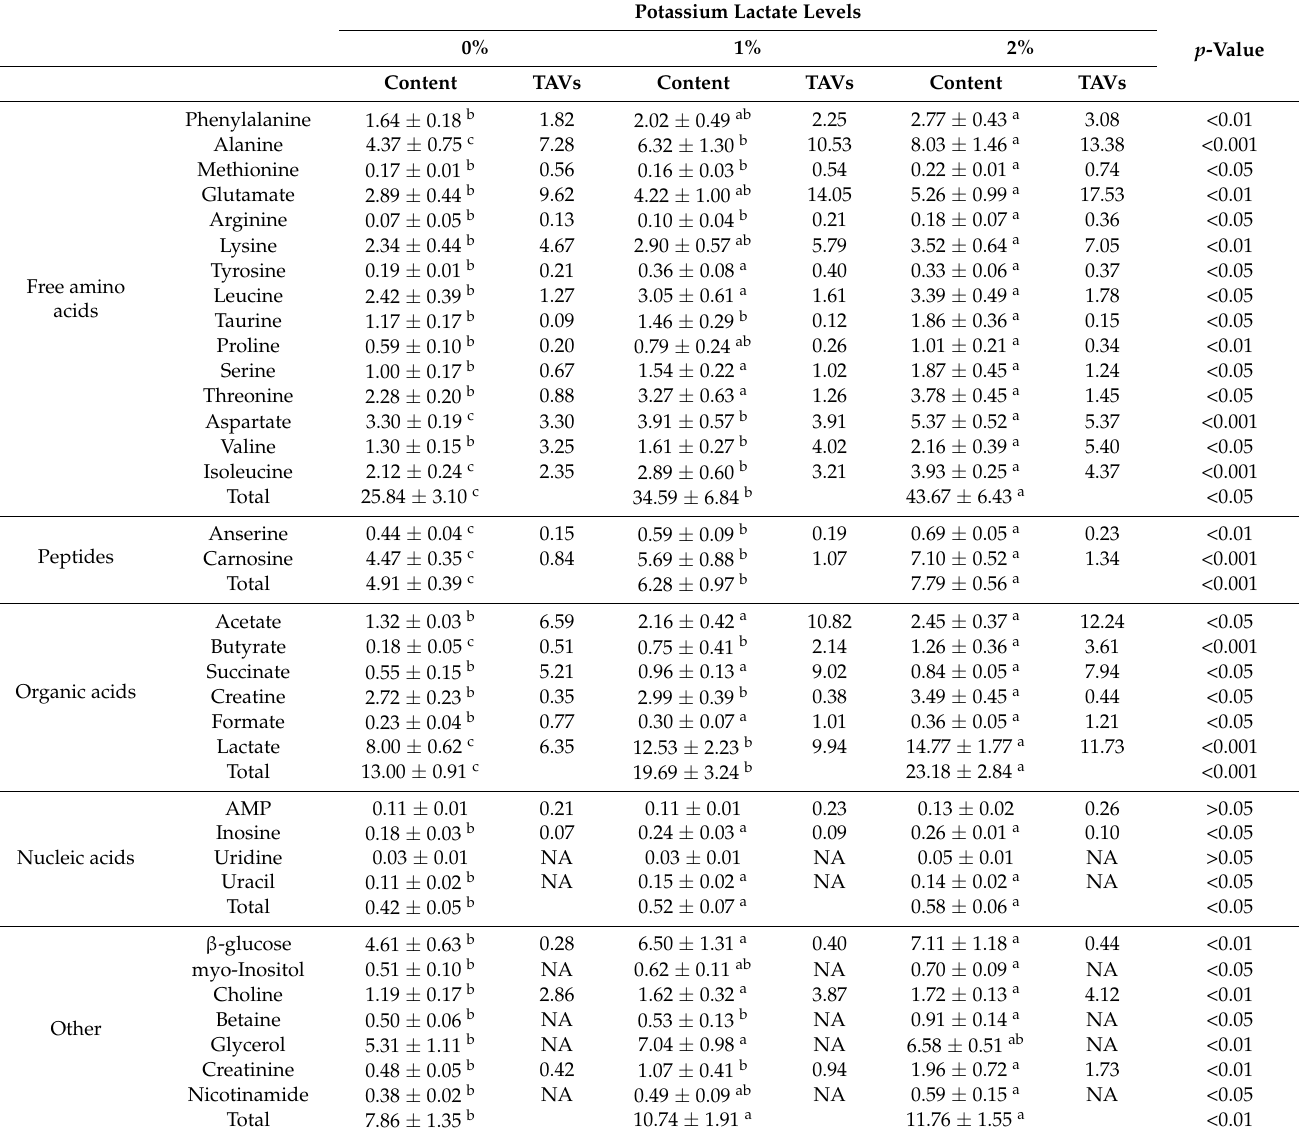
Table 1. Metabolite content of Rugao ham (mg/g) and taste active values